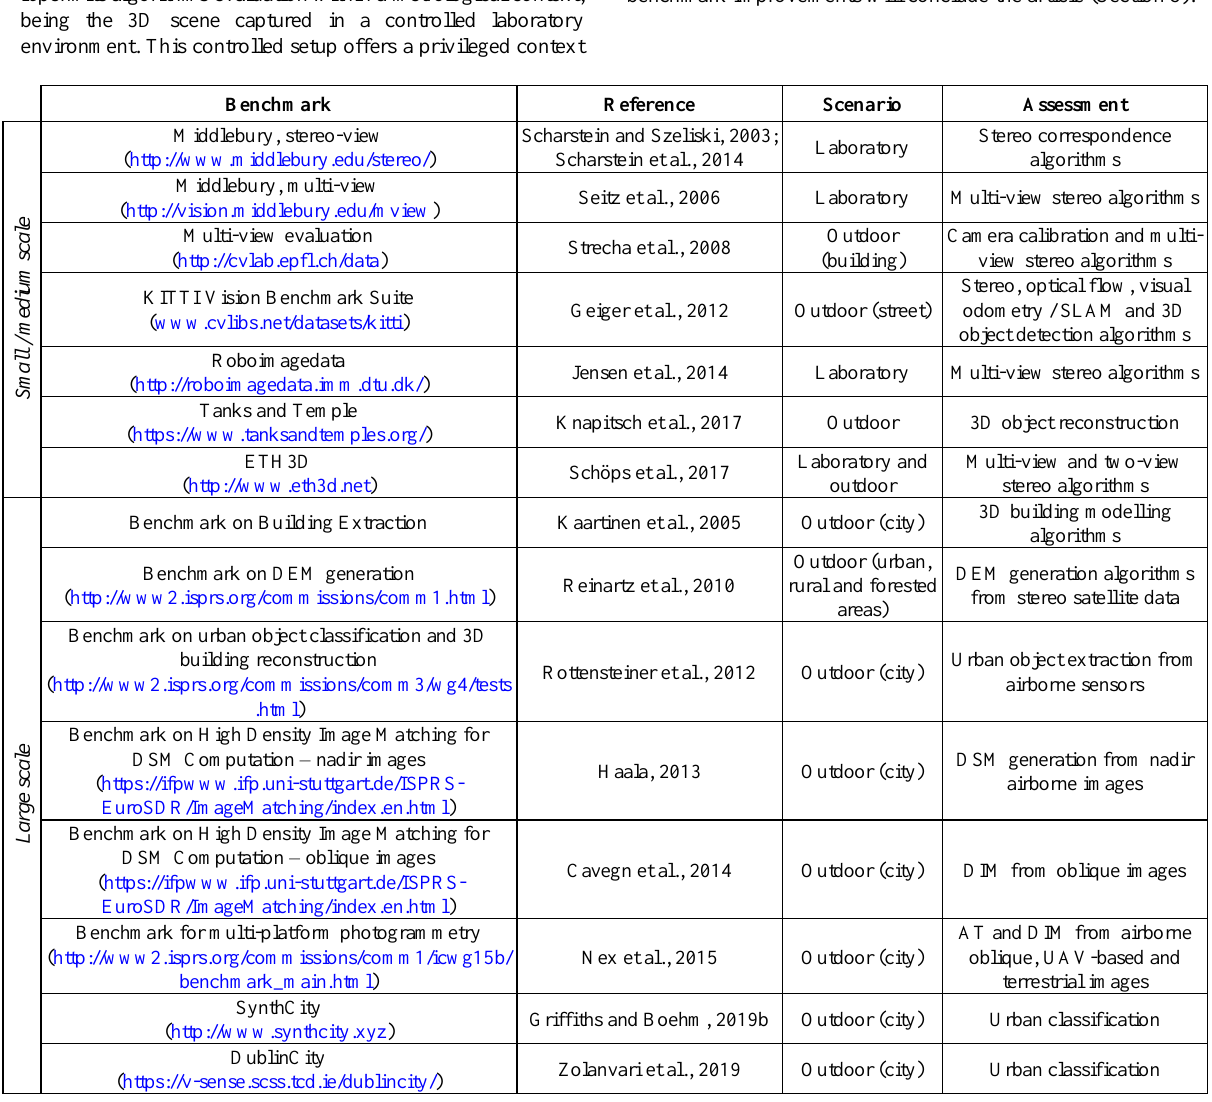
Table 1. Overview of state-of-the-art benchmark initiatives undertaken by the computer vision and geospatial communities in the fields of image-based 3D geometry reconstruction and scene